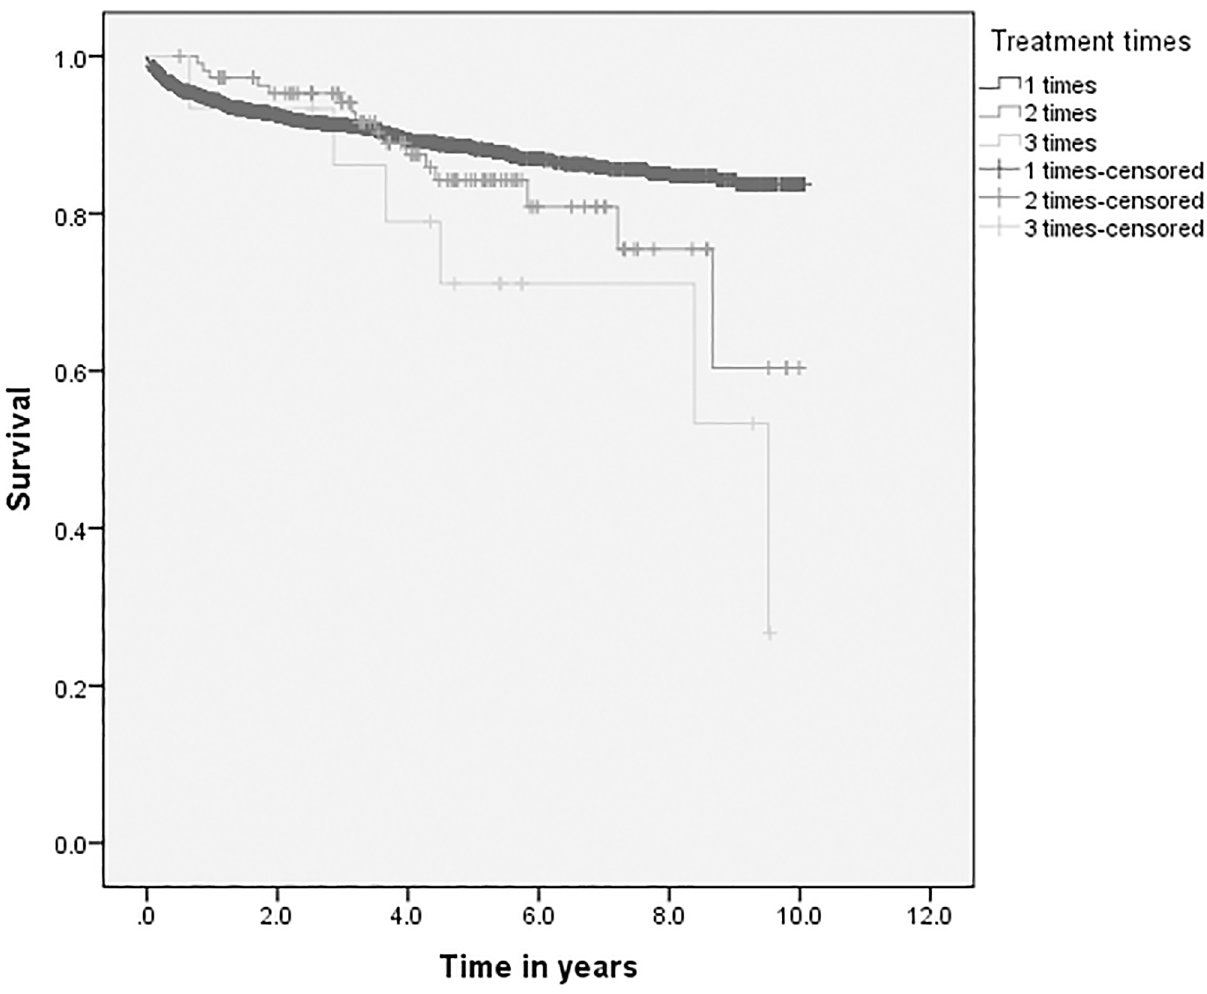
Fig 3. Survival probability of TB patients by treatment times in Dale district, South